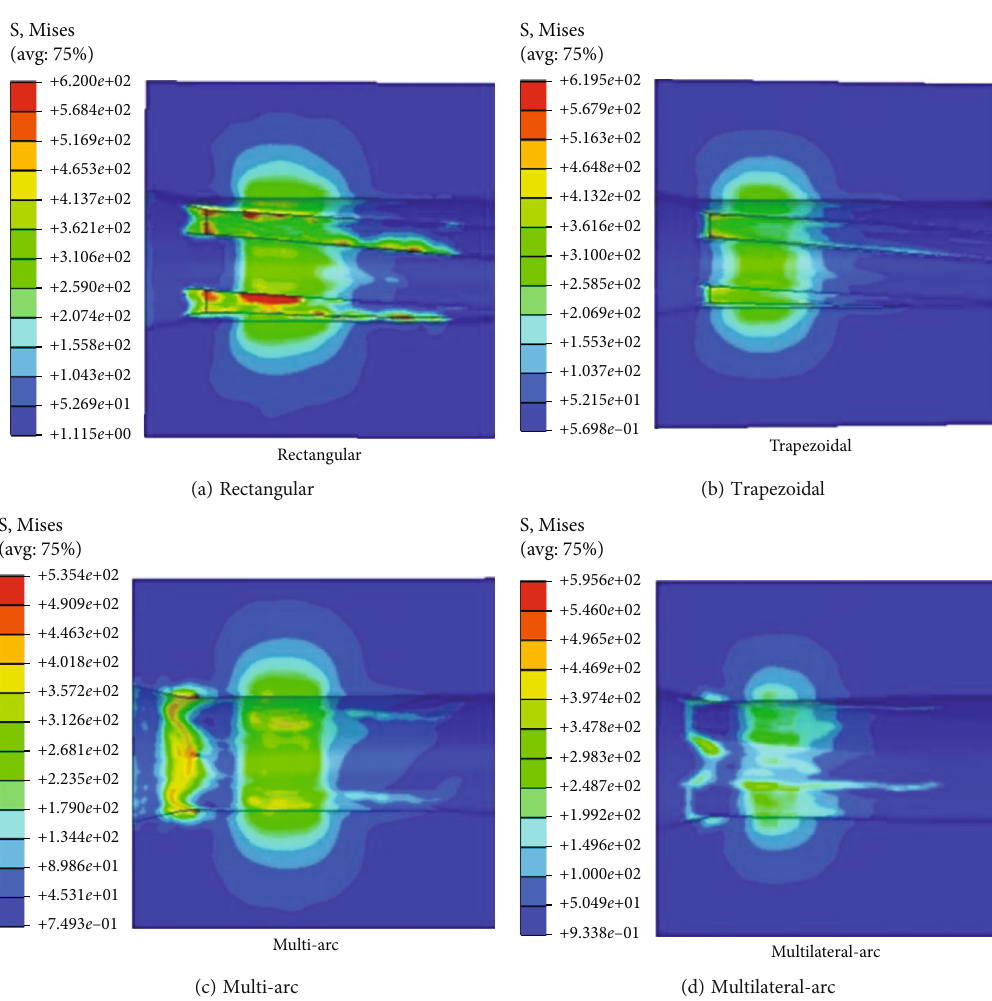
Figure 15: Nephograms of the barrel stress at the completion of bullet engraving into the ri fl ed